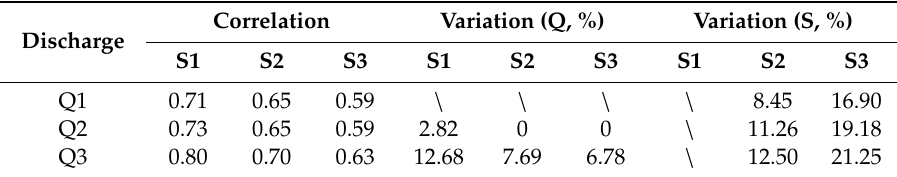
Table 4. The correlation between the front bend and back bend and its variation relative to S1 and Q1. Correlation Variation (Q, %) Variation (S, %) Discharge S1 S2 S3 S1